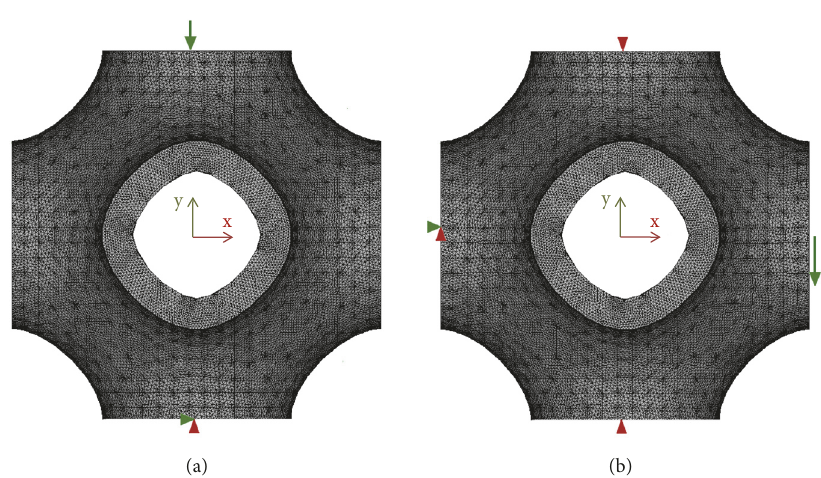
Figure 18: Loading configurations considered: (a) uniaxial compression load; (b) shear